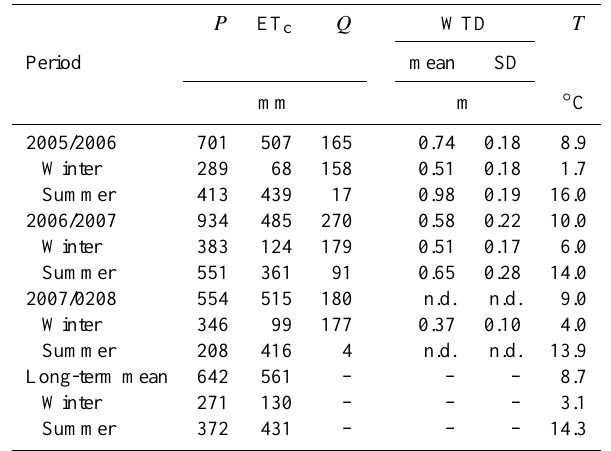
Table 2. Hydrological and meteorological conditions during the study period: precipitation ( P ), reference crop evapotranspiration (ET c ), discharge at the outlet ( Q ), mean and standard deviation (SD) water table depth (WTD) and temperature ( T ). Long-term averages: German Weather Service raster data 1990–2011. No groundwater level data are available for summer 2008 (n.d.: not de- termined).